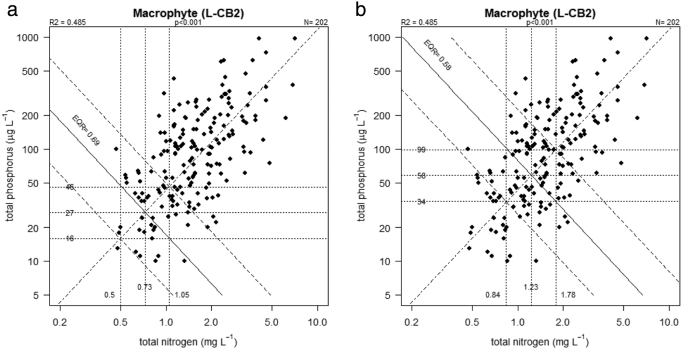
Relationship between mean TP and TN in high alkalinity very shallow lakes (L-CB2). Dotted lines show contours of predicted TN and TP concentration when macrophyte EQR is at a) high/good and b) good/moderate boundary (±25th & 75th residuals of prediction). Horizontal and vertical lines show intersection with RMA regression of observed TP and TN showing good moderate boundary concentrations.